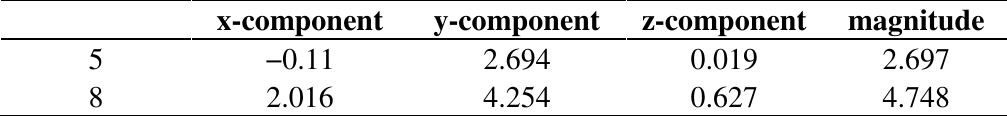
Table 3. The dipole moments (Debye) of 5 and 8